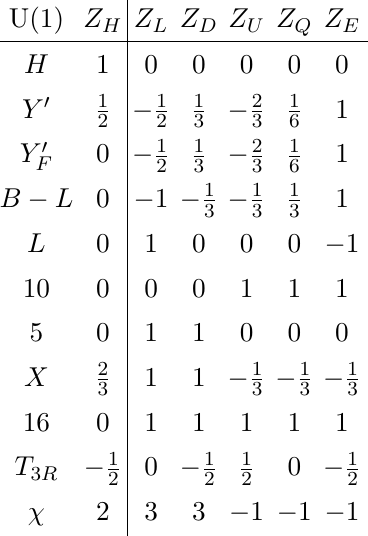
Table 2. Charges of frequently studied Z 0 Propor- tionality constants have sometimes been omitted.